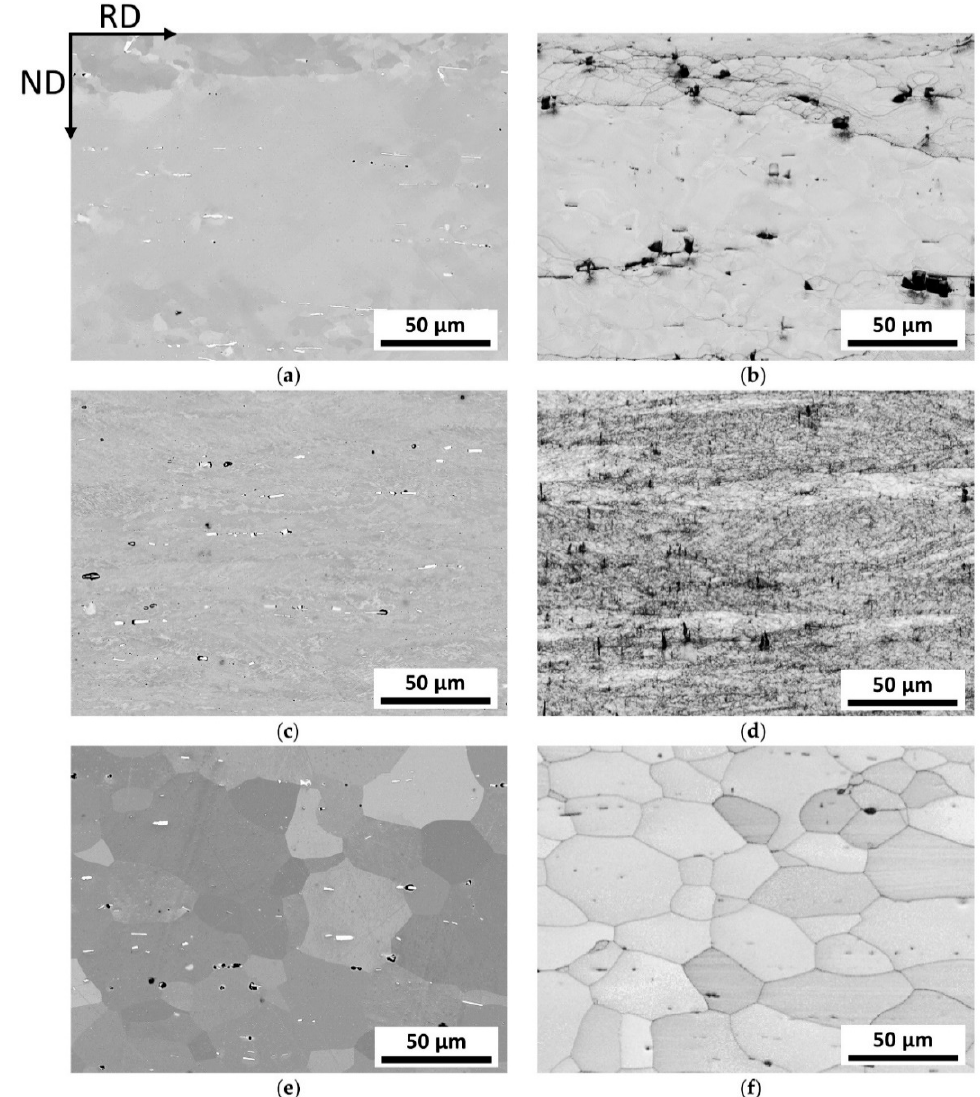
Figure 5. Microstructure evolution of the laboratory processed EN AW-6016 plotted in the TD-plane; ( a , c , e ) show BSE-images of the ( a ) hot-rolled, ( c ) cold-rolled (after IA), and ( e ) soft annealed state, respectively; ( b , d , f ) show band contrast maps of the ( b ) hot-rolled, ( d ) cold-rolled (after IA), and ( f ) solution annealed state, respectively.